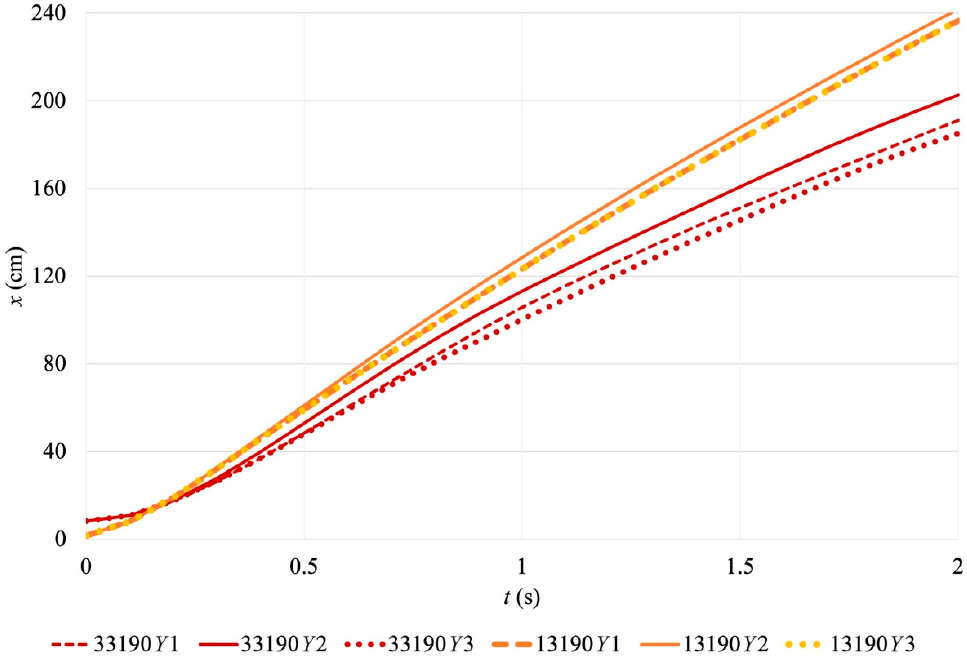
Figure 17. Comparison of the location of each row’s center of gravity in the x direction after starting the drift. the